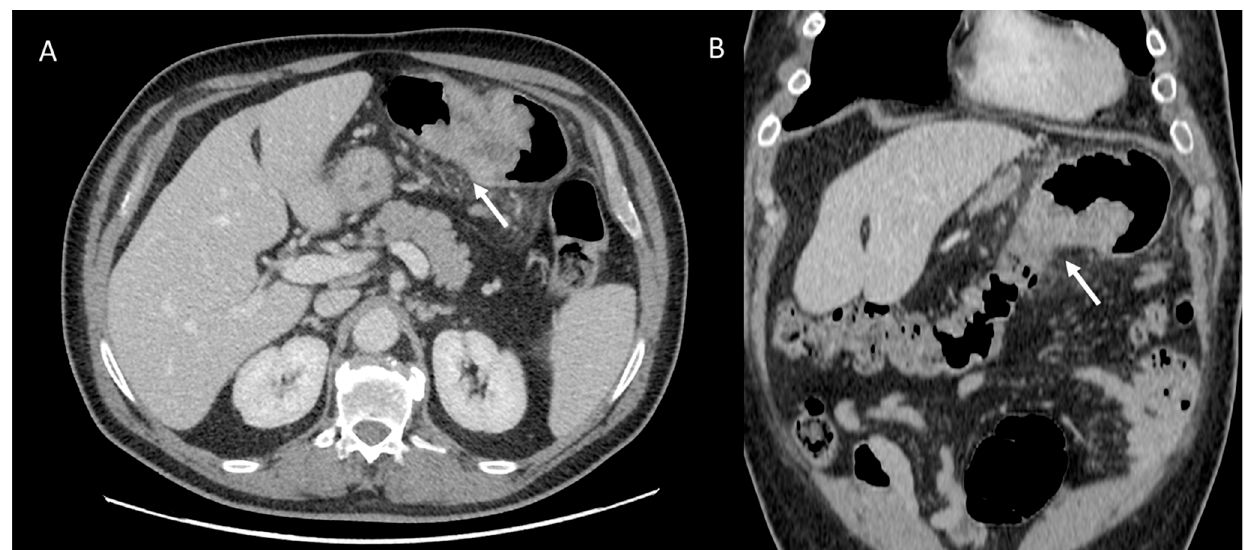
Figure 7. Man with transverse colon cancer (white arrows): in ( A ) (axial) and ( B ) (coronal) CT as-